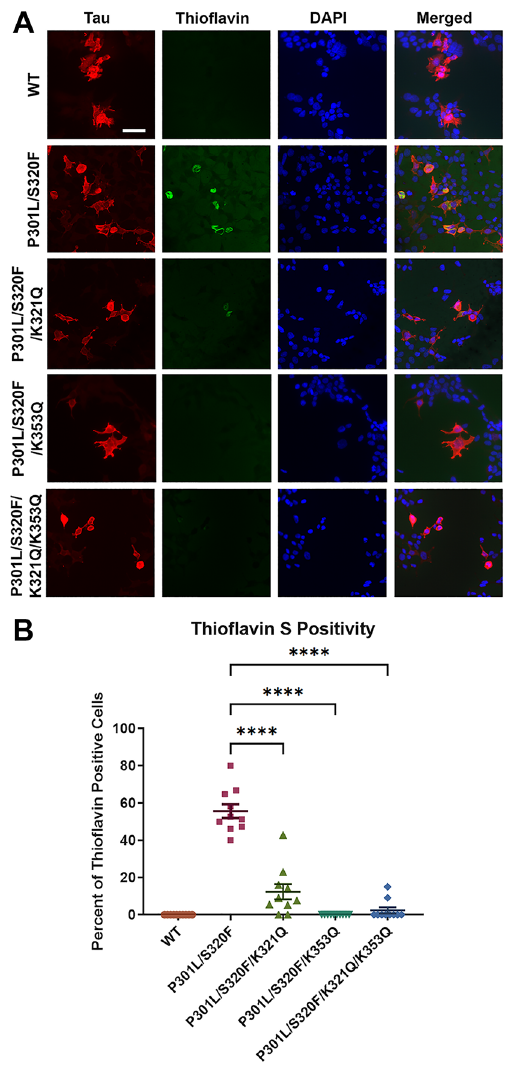
Figure 6. In the context of the P301L/S320F aggregation mutations, K321Q and K353Q acetylmimetics disrupt conformational amyloid structure as shown by reduced Thioflavin reactivity. (A) HEK293T cells were transfected to express WT, P301L/S320F, P301L/S320F/K321Q, P301L/S320F/K353Q, or P301L/S320F/ K321Q/K353Q 0N4R tau. Cells were plated onto slides and labeled for fluorescence with DAPI for nuclei, 3026 antibody/Alexa 594 for total tau (red), and Thioflavin S for amyloid structure (green). ( B ) Graph shows the ratio of thioflavin positive to tau positive cells calculated from 10 different ×20 fields for each group. One- way ANOVA with Dunnett’s test was performed with N = 10 for WT tau and mutations. ****p < 0.0001. Scale bar = 50